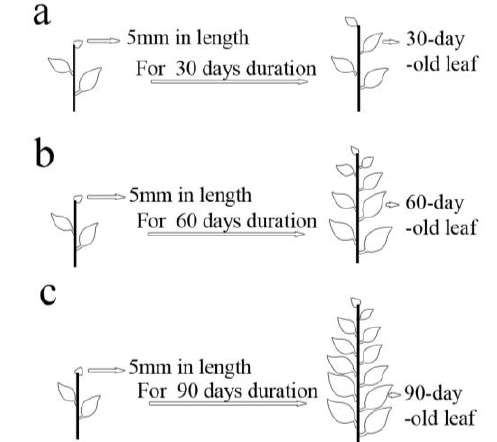
Figure 3. Leaf age definition diagram. Leaf age was defined as 30-, 60-, and 90-day-old growth from a 5 mm leaf in length.